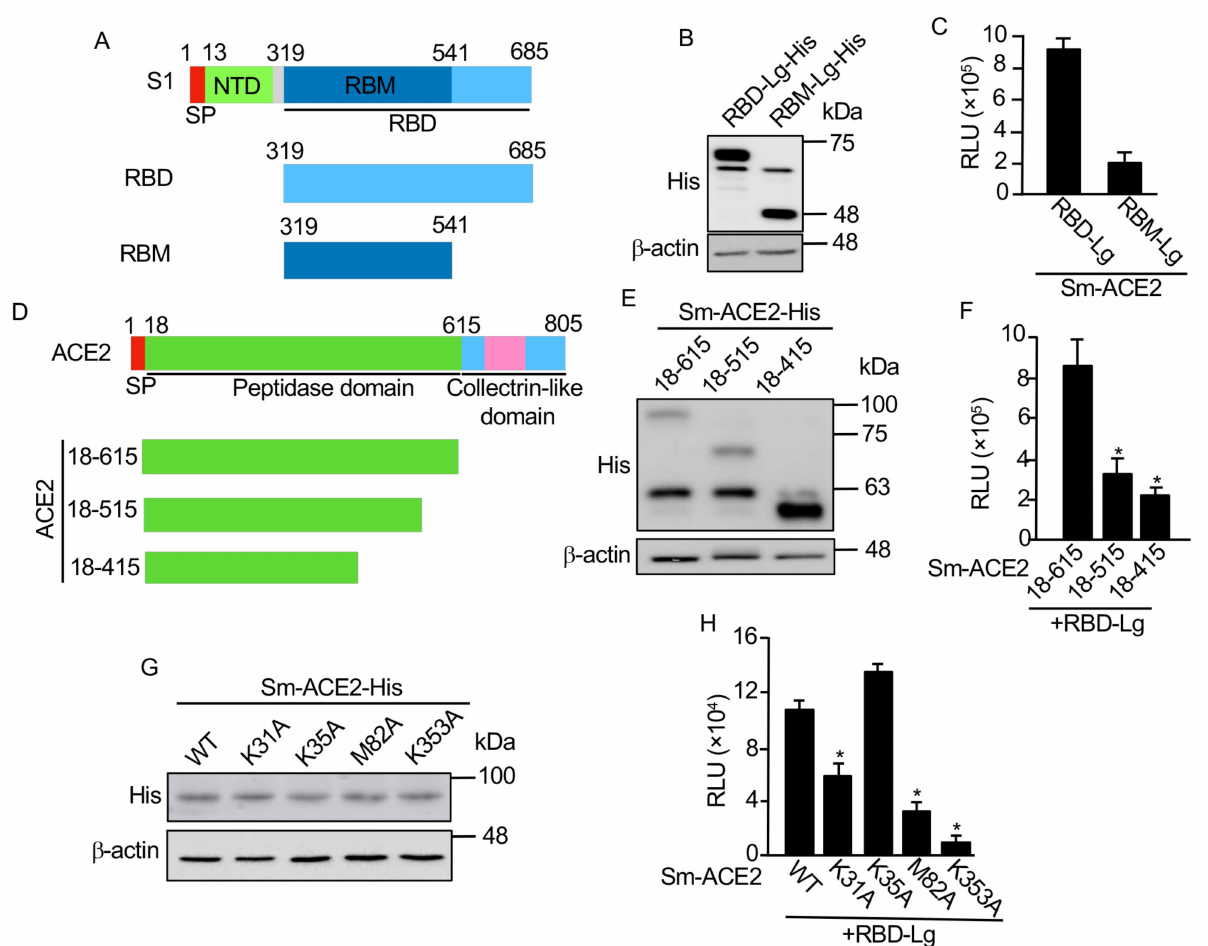
Figure 2. Mapping minimum region and critical residues for RBD:ACE2 PPI. ( A ) Schematic of RBD deletions. RBD, receptor binding domain; SP, signal peptide; NTD, N-terminal domain; RBM, receptor binding motif. ( B , E , G ) Western blot analysis of protein expression. ( C , F , H ) In vitro luciferase assay. Equal amounts (1 µ g) of each biosensor component were incubated together for 30 min, followed by luciferase assay; ( D ) Schematic of ACE2 deletions. Experimental procedures and labels are as described in Figure 1. *, p <